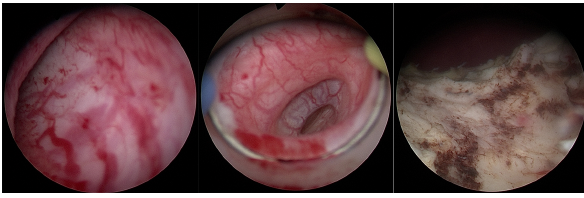
Fig. 3. The ureterocele was resected using a resectoscope